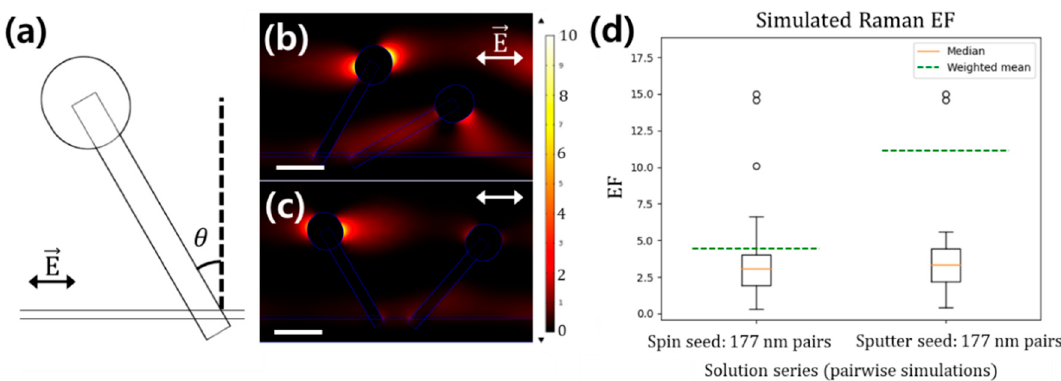
Figure 4. Comparison of simulated enhancement factors (EFs) derived by weighing pairwise Au-covered ZnO nanorod finite element method (FEM) calculations tilted based on their expected frequencies in the spin-seeded and sputter-seeded samples. ( a ) Nanorod showing its normal angle to the surface. ( b ) Pair of nanorods with angles 30 ° and 60 ° , scale bars 200 nm. ( c ) Pair of nanorods with angles − 30 ° and 30 ° , scale bars 200 nm. Arrows depict the incident electric field polarization. ( d ) Distribution of simulated enhancement factor for the nanorod pairs. Averages weighted by the experimental angular distribution are shown across each boxplot as a dashed green line. (N = 128).